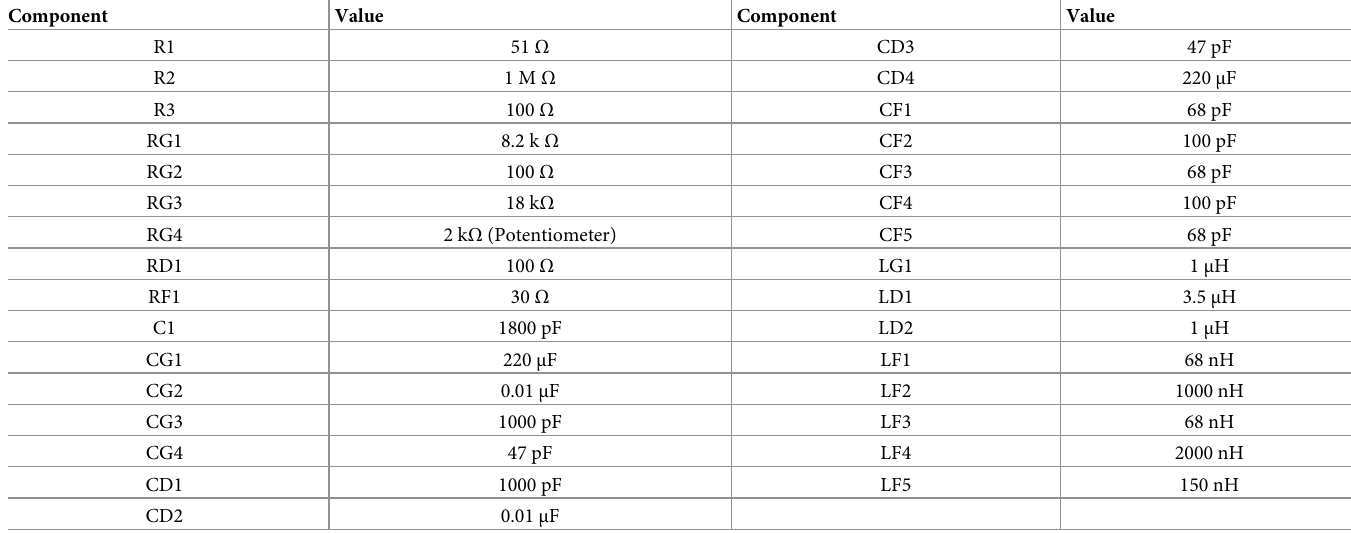
Table 1. Numerical values of circuit elements in Fig 5.